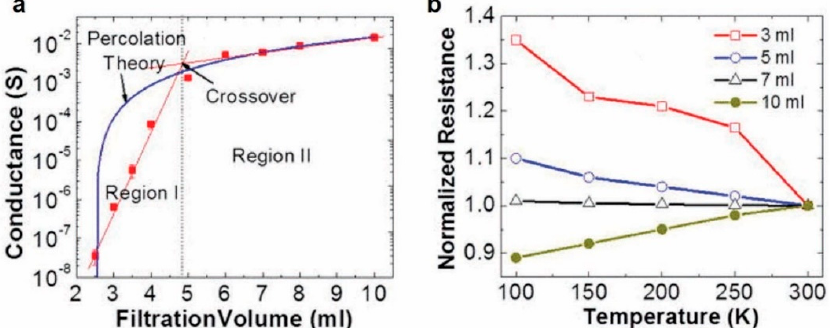
Figure 8. ( a ) Conductance (S) vs. filtration volume (mL) for the randomly stacked graphene flakes. ( b ) Normalized resistance vs. temperature (K) for various filtration volumes from 3 to 10 mL [18]. Reproduced with permission from AIP Publishing.